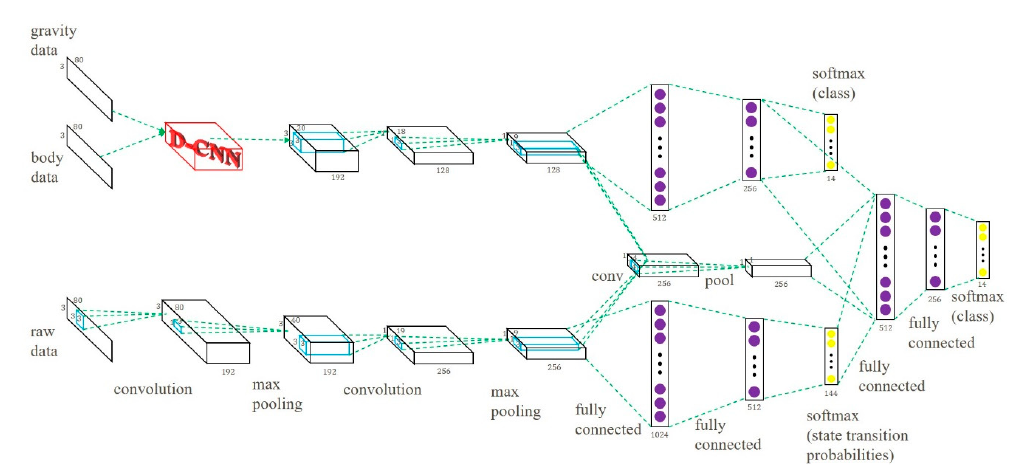
Figure 4. Multipath CNN model with D-CNN. 4. Sensor-Based Rehabilitation Exercise Evaluation